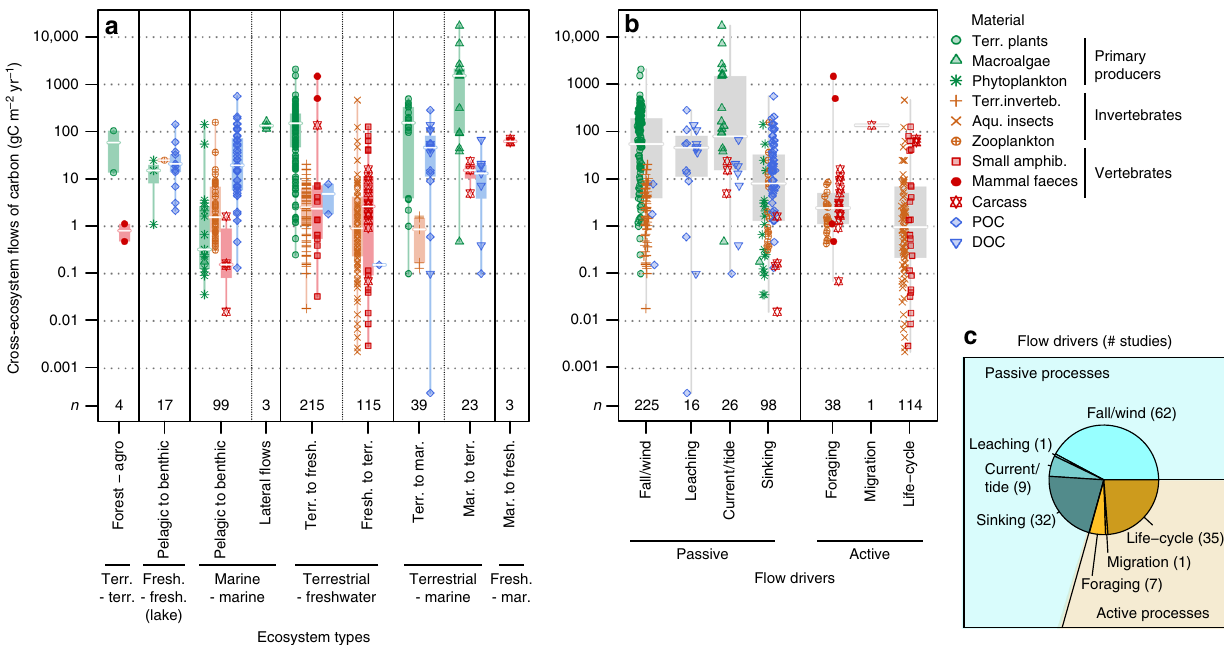
Fig. 2 Cross-ecosystem carbon fl ows. Values are provided a by types of ecosystems connected by the fl ows, with vertical labels specifying ecosystems (agro stands for agro-ecosystem) and fl ow direction, and b by underlying fl ow drivers. Values are in gC m − 2 y − 1 on a log scale and n indicates the number of data points. The areal unit, m 2 , refers to the recipient ecosystem. Boxplots give median (white line), 25 and 75% percentiles (box), and range